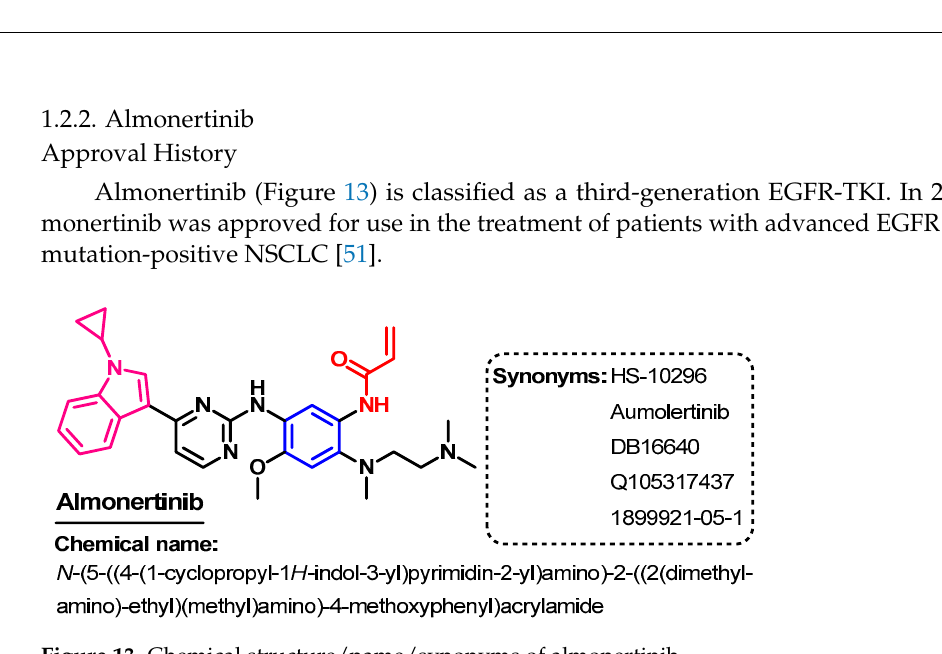
Figure 13. Chemical structure/name/synonyms of almonertinib.